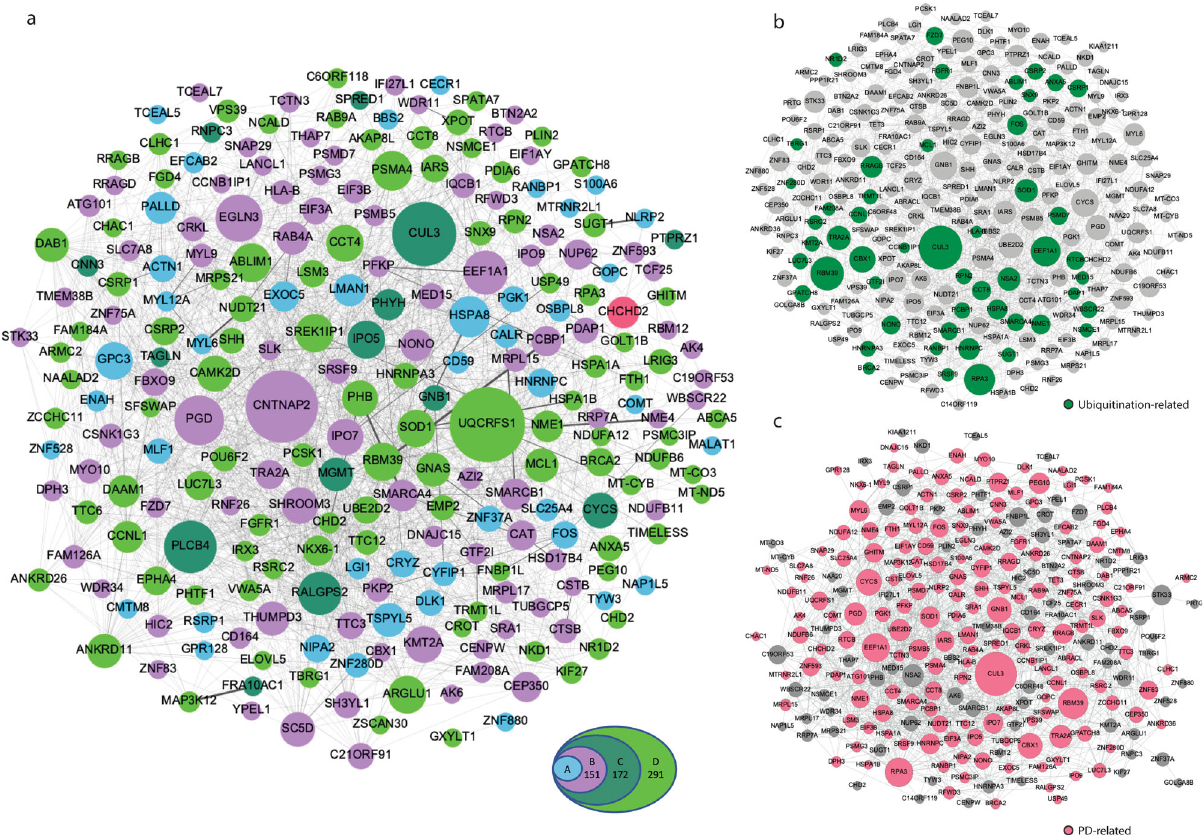
Fig. 6 Network analysis. a Protein – protein interaction network based on known interactions available through the STRING 59 and GeneMANIA 61 databases. Only strong interactions were retained, predicted interactions or text associations were omitted (see Methods). Betweenness centrality was used to illustrate the relative importance of each node within the network through the level of its connectedness to other proteins. The larger the circle, the more partners the node is connected to. The colors represent the four DEG sets, with the top 56 DEGs (group A) in light blue, group B in purple, group C in dark green, and group D in light green. Each set consists of genes of the previous set plus additional genes identi fi ed by the new parameters. CHCHD2 (pink, part of group B) is a DEG, which has recently been identi fi ed as a PARK gene. Random selection of genes from genes detected by sc-RNAseq did not lead to a network formation (Supplementary Fig. 5). b DEGs which play a role in ubiquitination. Additional functional pathways are listed in Supplementary Fig. 7 and Supplementary Data 3. Speci fi c connections to ubiquitination proteins are shown in Supplementary Fig. 8. c Based on the literature, 68% of the DEGs of this network are already known to be associated with PD (for references see Supplementary Data 4). Supplementary Fig. 9 shows which genes/proteins of the network directly interact with PARK genes through known protein – protein interactions. The topology of all three networks is the same, the different appearance is a result of a separate analysis run, but the connections and size of the nodes remain